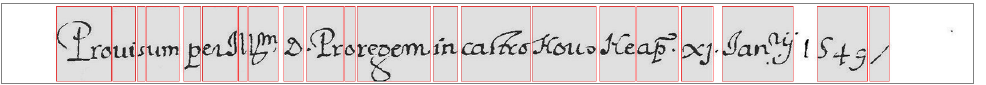
Figure 7. Examples of preliminary word segmentation: the bounding boxes are represented as grey areas of the text line with red